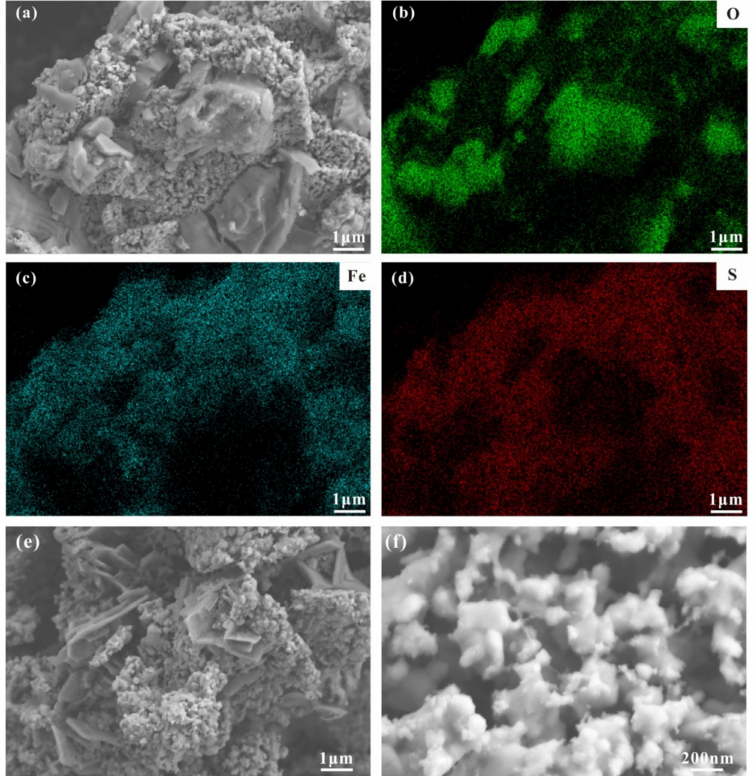
Figure 8. SEM images of a sulfidation product of jarosite residues: ( a ) sulfidation product at 500 ◦ C for 1.5 h; ( b – d ) element mappings of ( a ); ( e , f ) sulfidation product at 575 ◦ C for 1.5